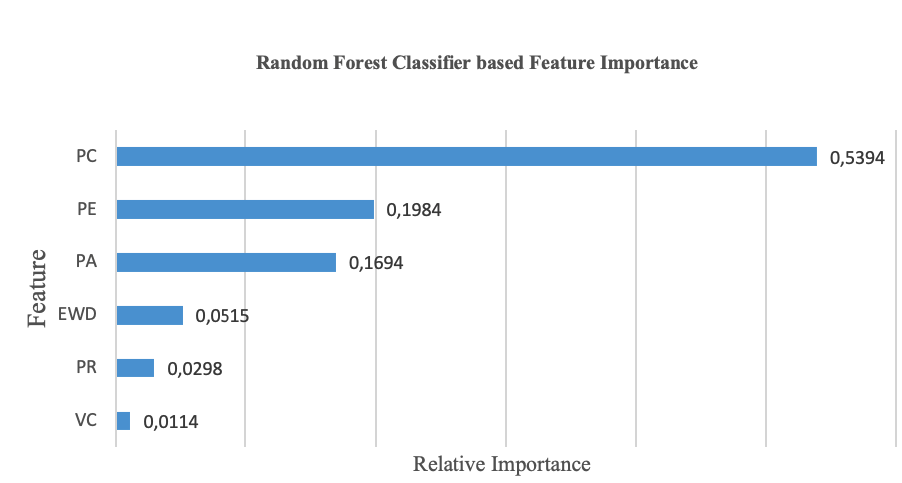
Figure 4 : Relative Feature Importance (Sensitivity Analysis using Naive Bayes Classifier; Source: Adopted by